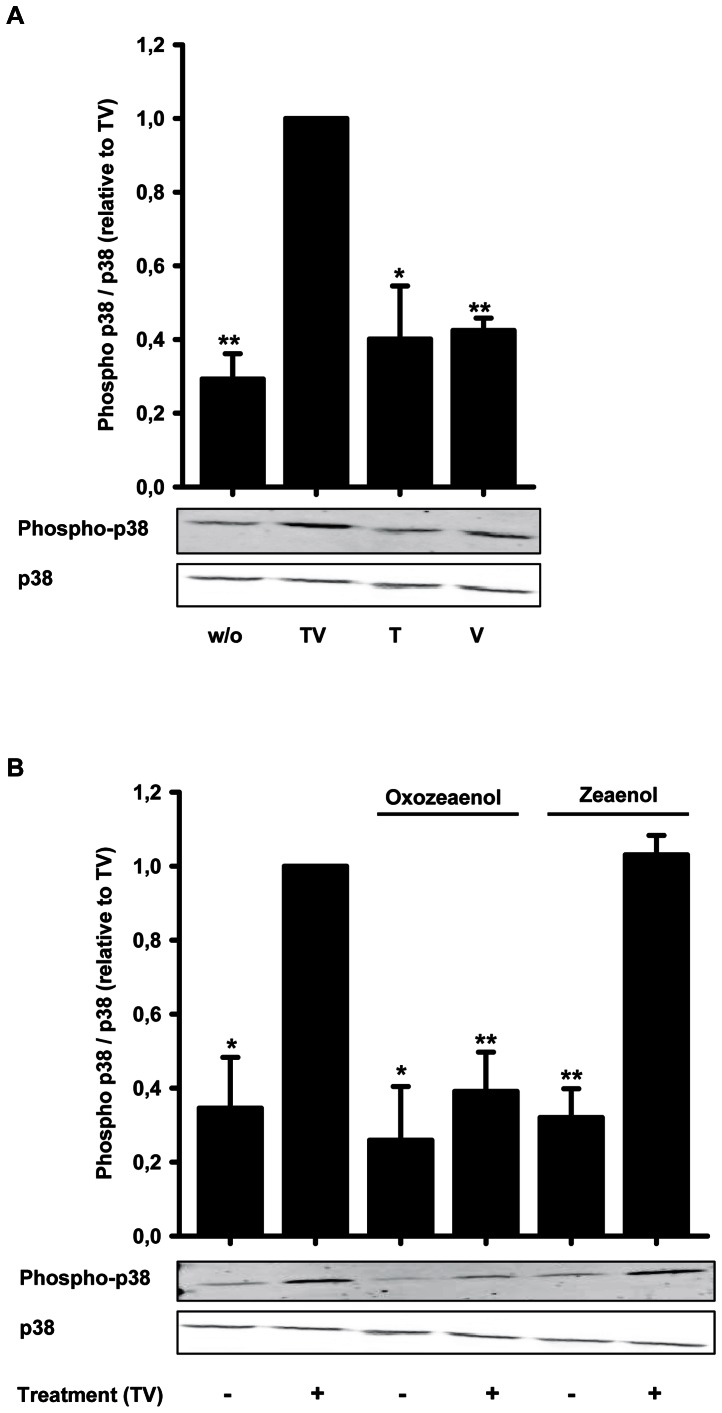
Western Blot analysis of p38 phosphorylation in dependence of treatment with TGF-β and/or 1α,25(OH)2D3.(A) Western Blot analysis of p38 protein and phosphorylated p38 protein in THP-1 incubated for 24 h with 1 ng/ml TGF-β (T), 50 nM 1α,25(OH)2D3 (V), both agents (TV) or without treatment (w/o). The relative phospho-p38 level (normalized to total p38 protein) of TGF-β/1α,25(OH)2D3 treated cells was set to 1. (B) THP-1 cells were treated with (TV) or without (w/o) 1 ng/ml TGF-β and 50 nM 1α,25(OH)2D3 for 24 h after 30 min pre-incubation with or without the indicated inhibitors. Applied concentrations of oxozeaenol and zeaenol were 0.3 µM, respectively. Phosphorylated p38 compared to whole p38 protein was analyzed by western blot. Relative protein amount of TGF-β/1α,25(OH)2D3 treated cells was set to 1. Statistical analysis of (A) and (B) was done with one sample t-test (*P<0.05; **P<0.01).